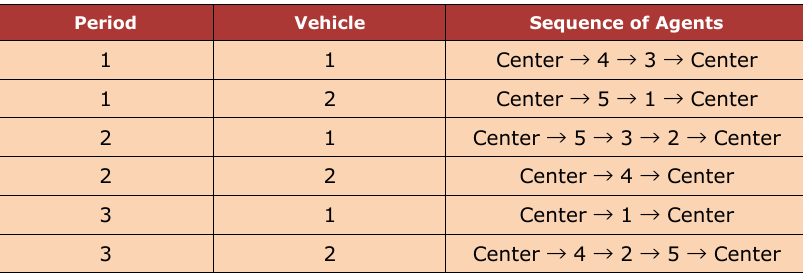
Table 1. Sequence of each vehicle in each period for chromosome represented in Figure